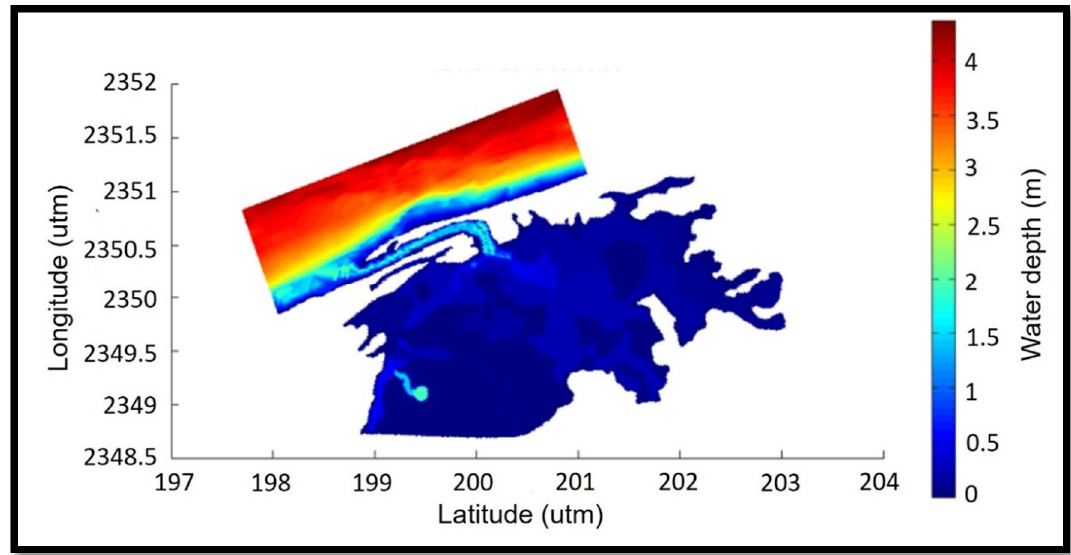
Figure A2. Bathymetry of the lagoon of La Carbonera and nearby marine area [33] .